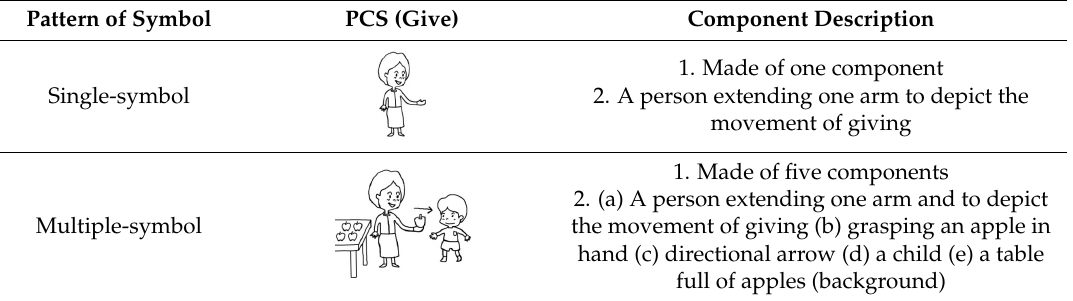
Table 2. PCS example and description.